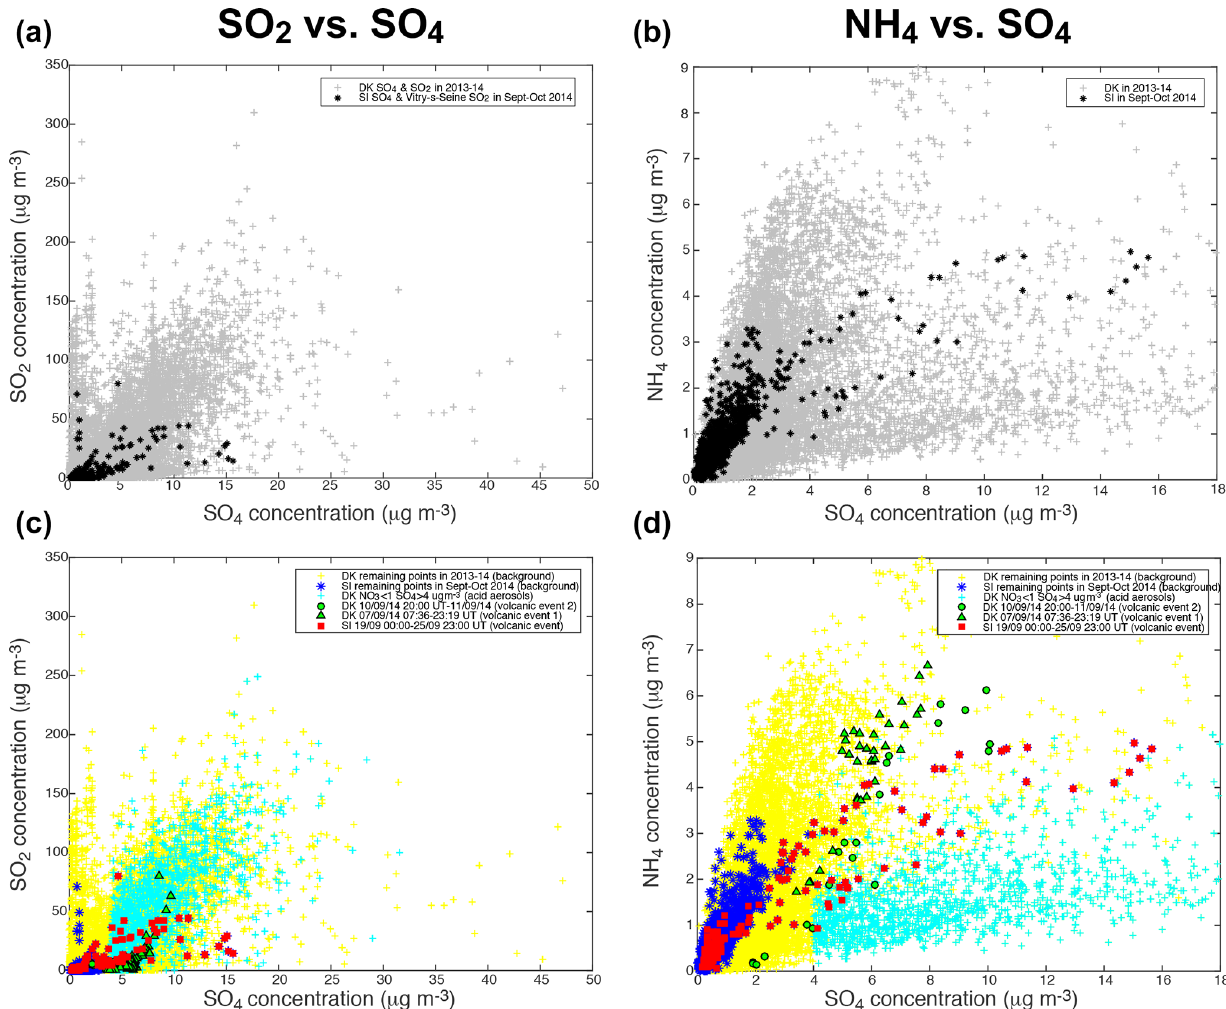
Figure 5. Scatter plots of (a, c) SO 2 (from Atmo Hauts-de-France station in Dunkirk or Airparif Vitry-sur-Seine station nearby SIRTA) and (b, d) ACSM NH 4 vs. ACSM SO 4 mass concentrations. (a, b) All available data at Dunkirk/Port-East (DK) over 15 July 2013–11 Septem- ber 2014 (grey), and at SIRTA (SI) and nearby Vitry-sur-Seine Airparif station for SO 2 over 1 September–31 October 2014 (black). (c, d) Red squares: SI data over 19 September 2014 00:00–25 September 2014 23:00UT (volcanic event), green triangles: DK data over 7 September 2014 07:36–23:19UT (volcanic event 1); green circles: DK data over 10 September 2014 20:00UT–11 September 2014 (end of data) (volcanic event 2); cyan crosses: DK data with mass concentrations of NO 3 < 1 and SO 4 > 4µgm − 3 (acidic aerosols); blue stars: SI remaining data (background); yellow crosses: DK remaining data